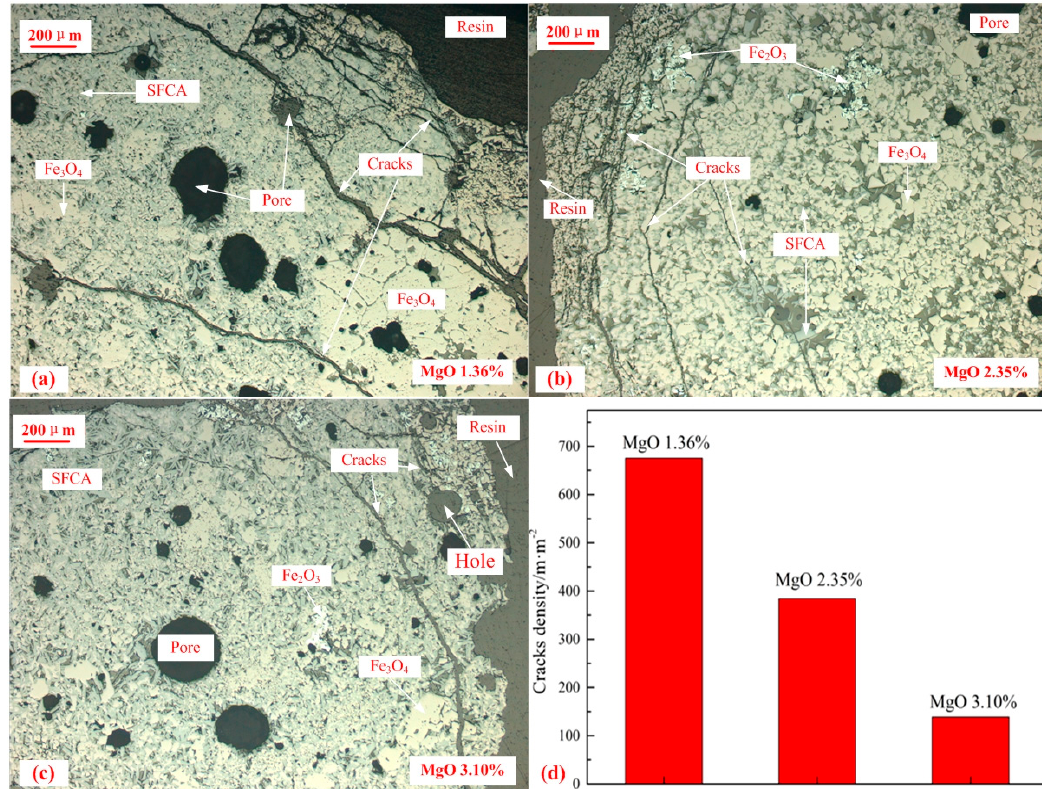
Figure 9. ( a ) Microstructure of reduced sinter containing 1.36% MgO; ( b ) microstructure of reduced sinter containing 2.35% MgO; ( c ) microstructure of reduced sinter containing 3.10% MgO; and ( d ) crack density of reduced sinter with different MgO content.